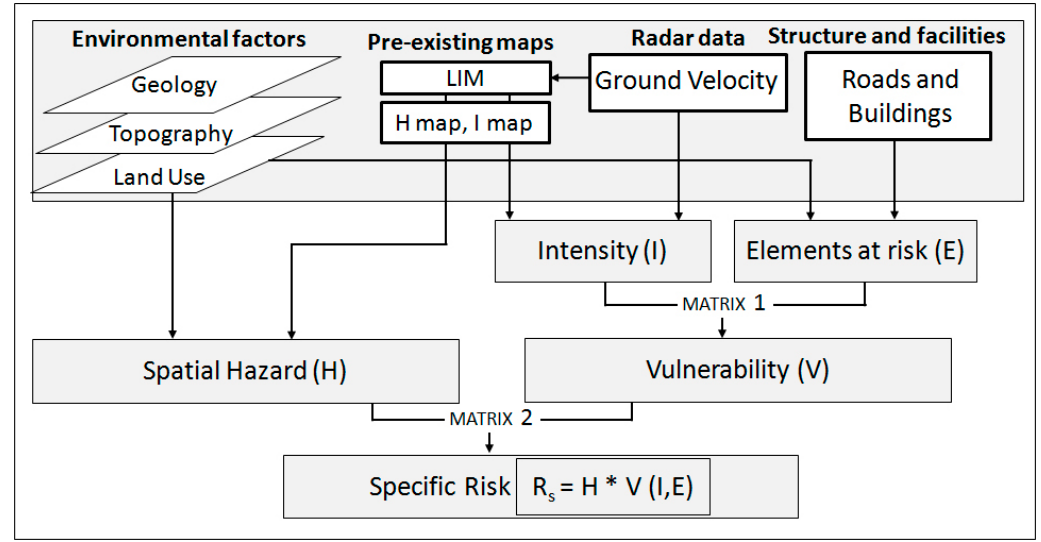
Figure 1. The work flowchart for the proposed landslide Specific Risk analysis.